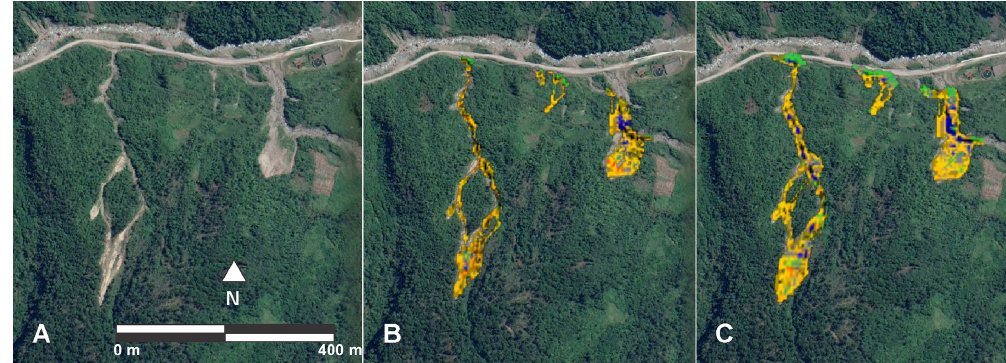
Figure 3. Comparison between historic landslides (a) and modeled landslides from a single run (b) , and from 50 runs (the cumulative